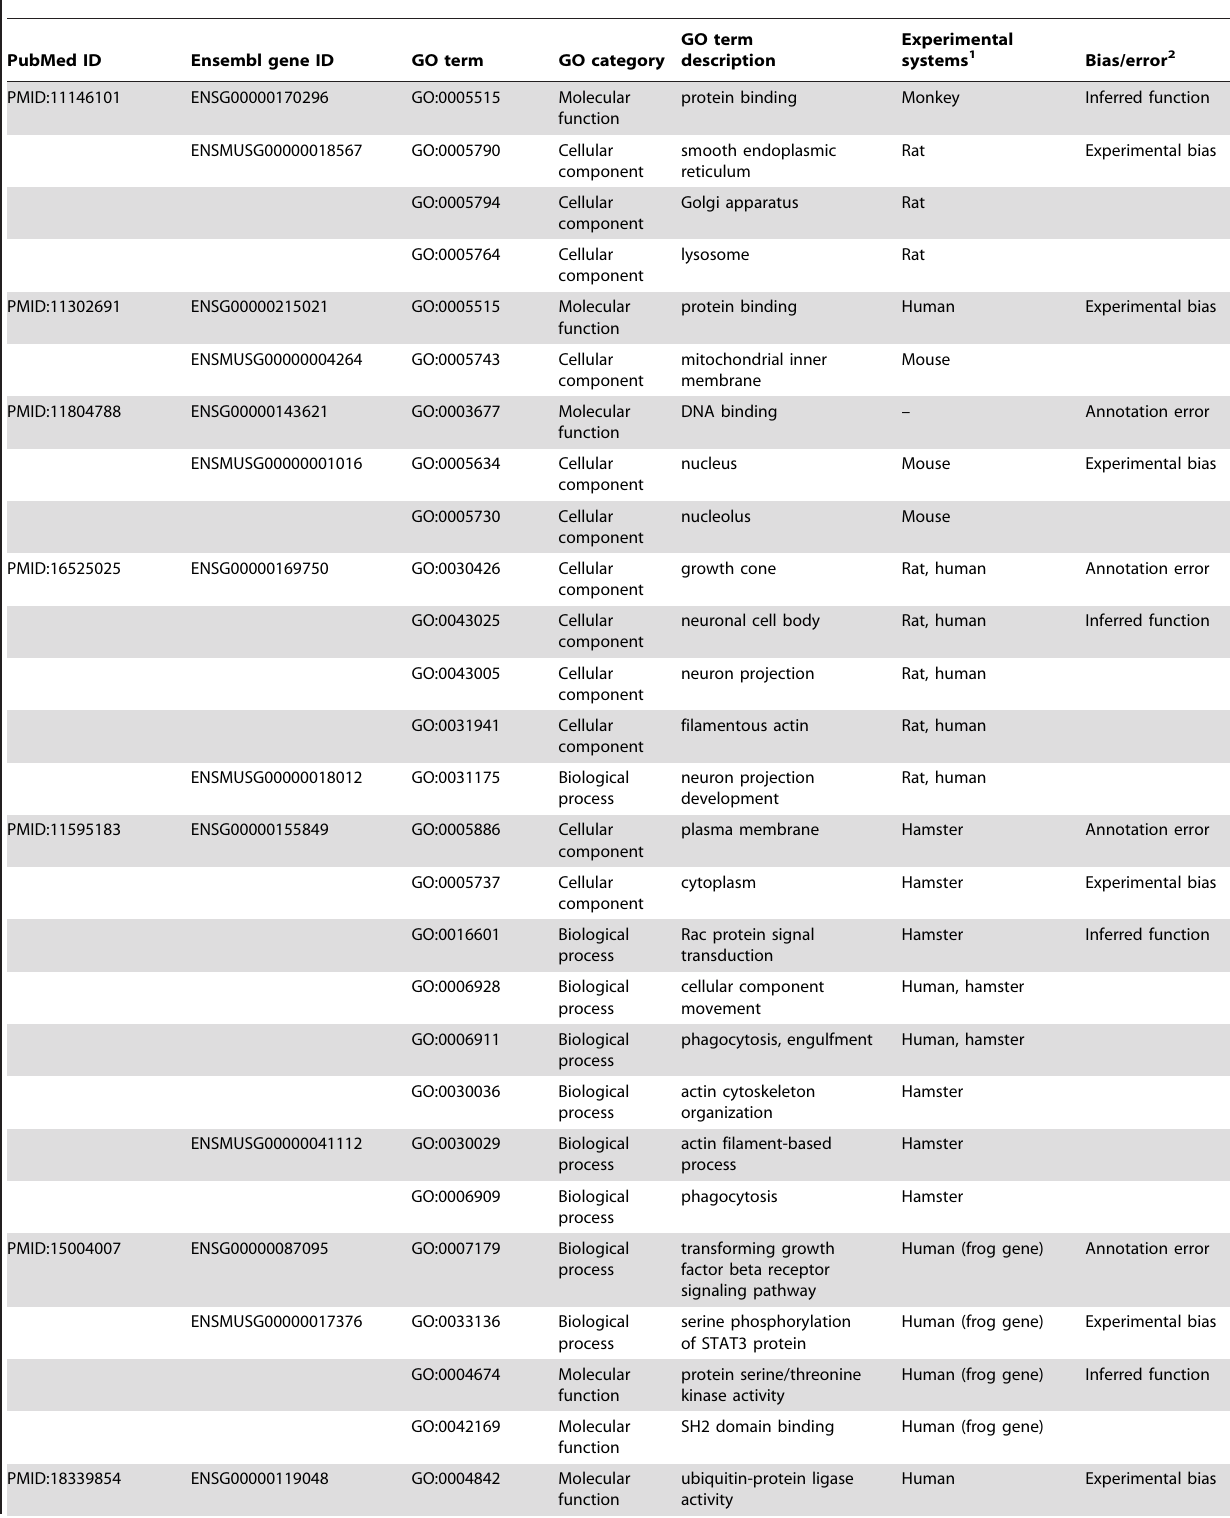
Table 1. Eight pairs of human-mouse orthologs with identical protein sequences but no overlapping GO annotations based on co- study